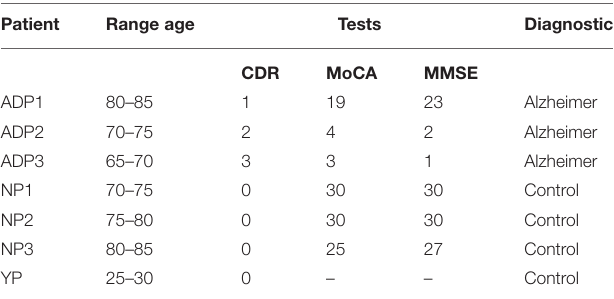
TABLE 1 | Demographic characteristics of the